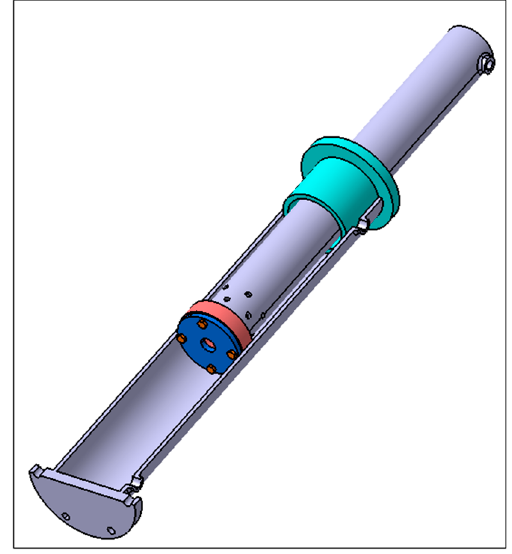
Figure 3. Structure chart of damper.